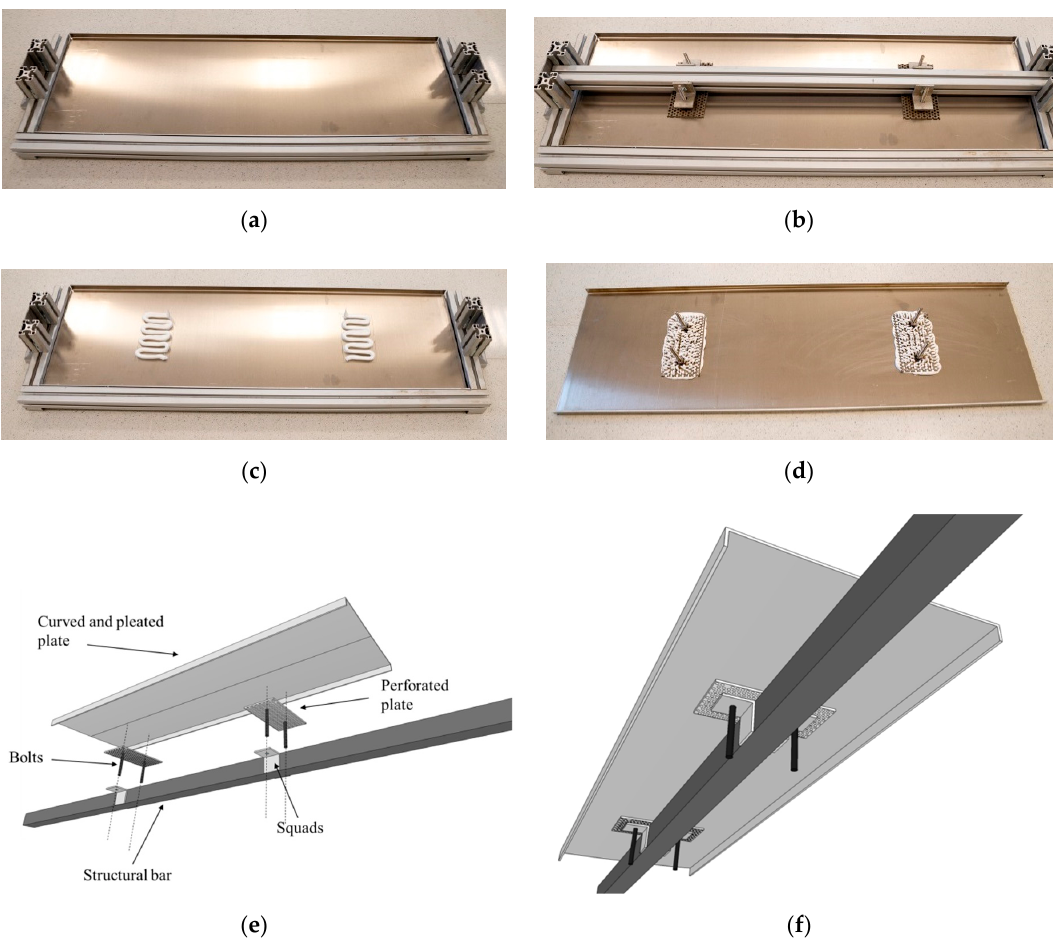
Figure 8. Assembly scheme of the suction cup into a mirror facet: (a) facet presented over the alignment device, (b) facet adjusted over the alignment device, (c) silicone cordon applied on the facet, (d) suction cups attached on the facet, (e) exploded view of the suction cup mounting process, and (f) suction cup mounted on the facet.